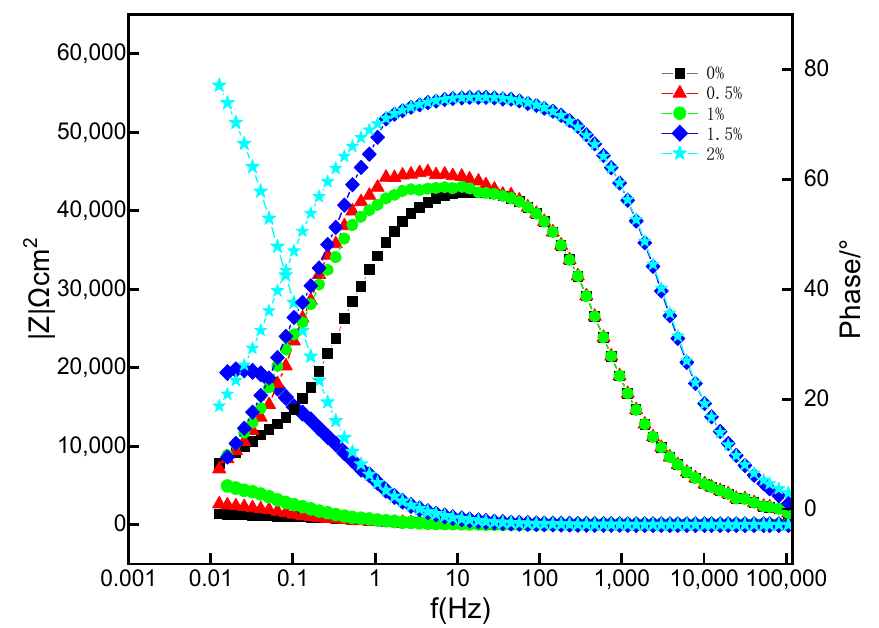
Figure 8. EIS in 3.5% NaCl solution: Bode plots. For the surfacing layer with different boron addition, the equivalent circuit, as shown in Figure 9, is used to fit the EIS data [14,15], and the results are shown in Table 5. Where RS is the electrolyte solution resistance, CPE 1 is the electric double-layer capacitance, Rt is the charge transfer resistance, CPE 2 is the passive film capacitance, and Rf is the passive film resistance. The smaller the R t value, the easier it is for ions to enter the electric double layer. The lower the R f value, the weaker the protection of the passive film. The smaller the CPE 1 , the fewer the number of surface defects of the passive film. The lower the CPE 2 , the stronger the protection of the passive film [16,17]. It can be seen from Table 6 that the CPE 1 and CPE 2 values of surfacing layers with different boron additions are very small, which indicates that their passive films are very stable. The passivation film resistance R f is greater than the charge transfer resistance R t , which indicates that the passivation film plays a major role in the corrosion resistance of the material, because when the boron addition is 2%, the CPE 1 value is the smallest and the Rf value is the highest, which indicates that the material contains a complete passivation film and corrosion